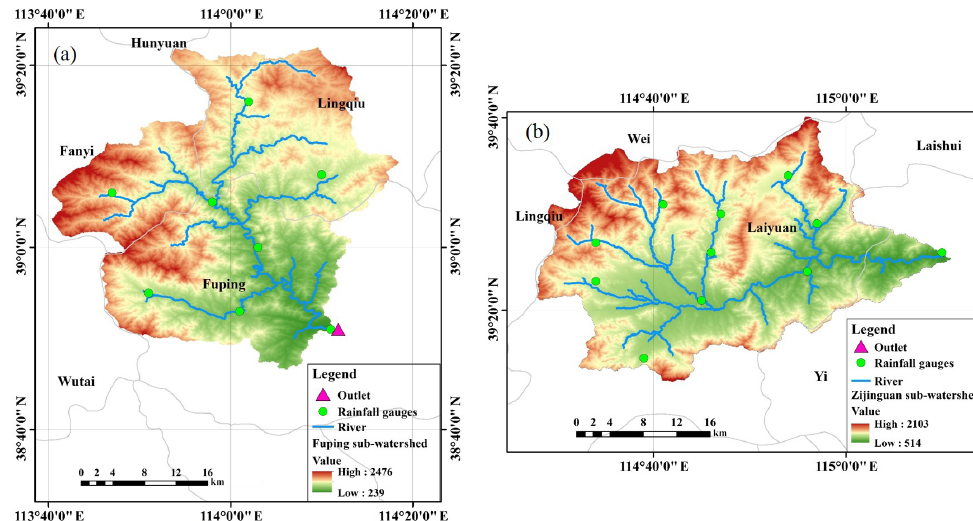
Figure 3. Topographic map of the two study sub-watersheds with the locations of rain and flow gauge